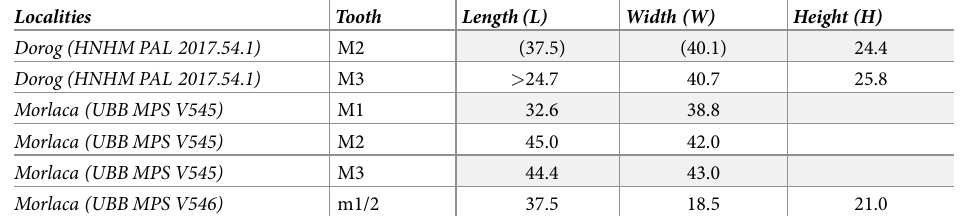
Table 3. Measurements (in mm) of the dentition of UBB MPS V545, UBB MPS V546 and HNHM PAL 2017.54.1, referred to Amynodontopsis aff. bodei .